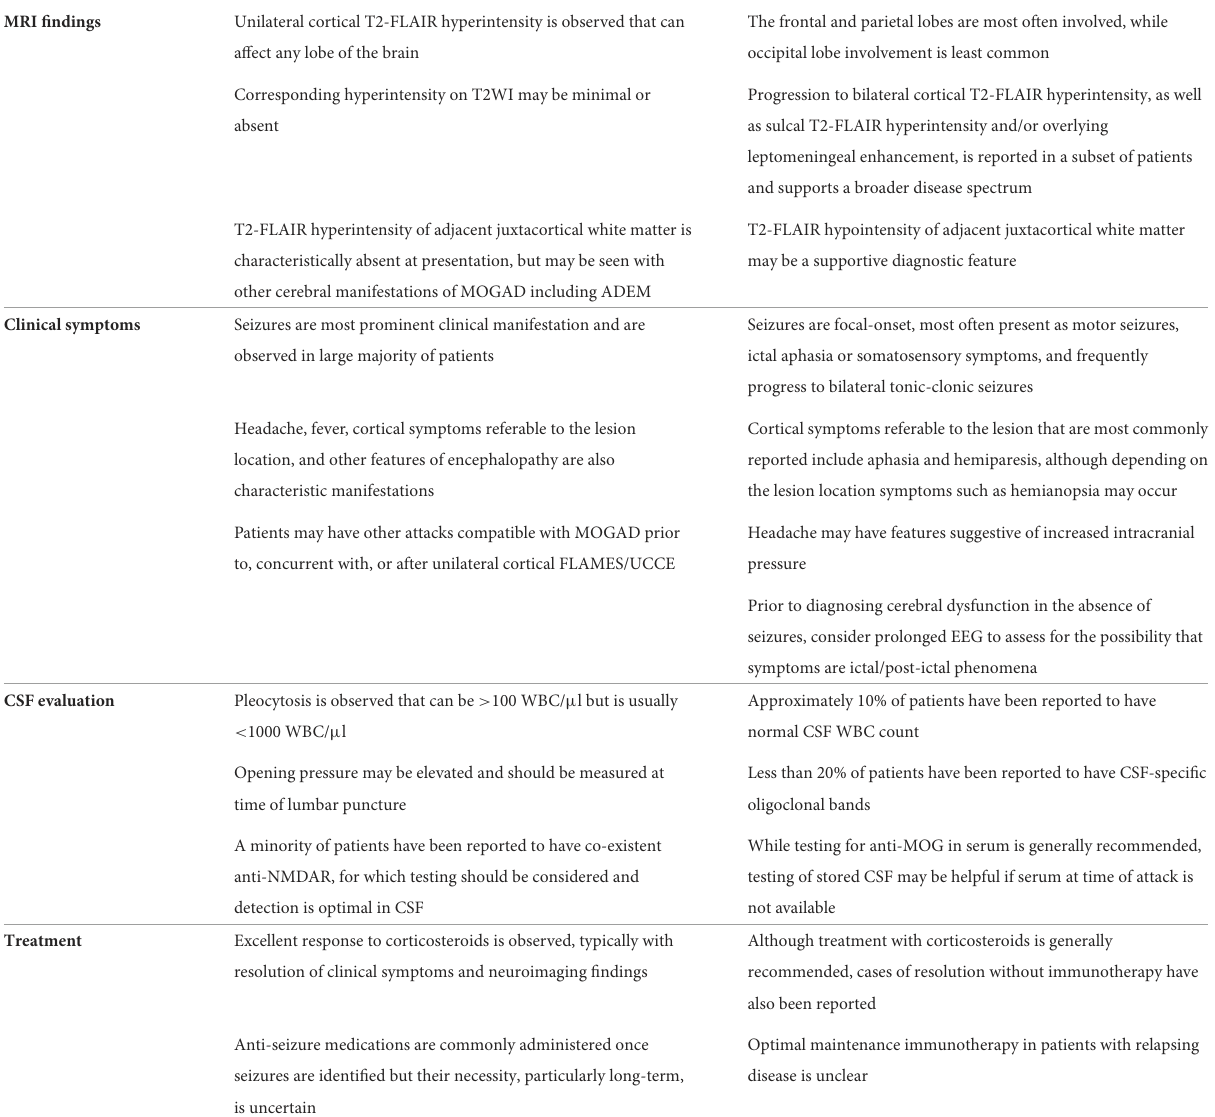
TABLE 1 Key features of unilateral cortical